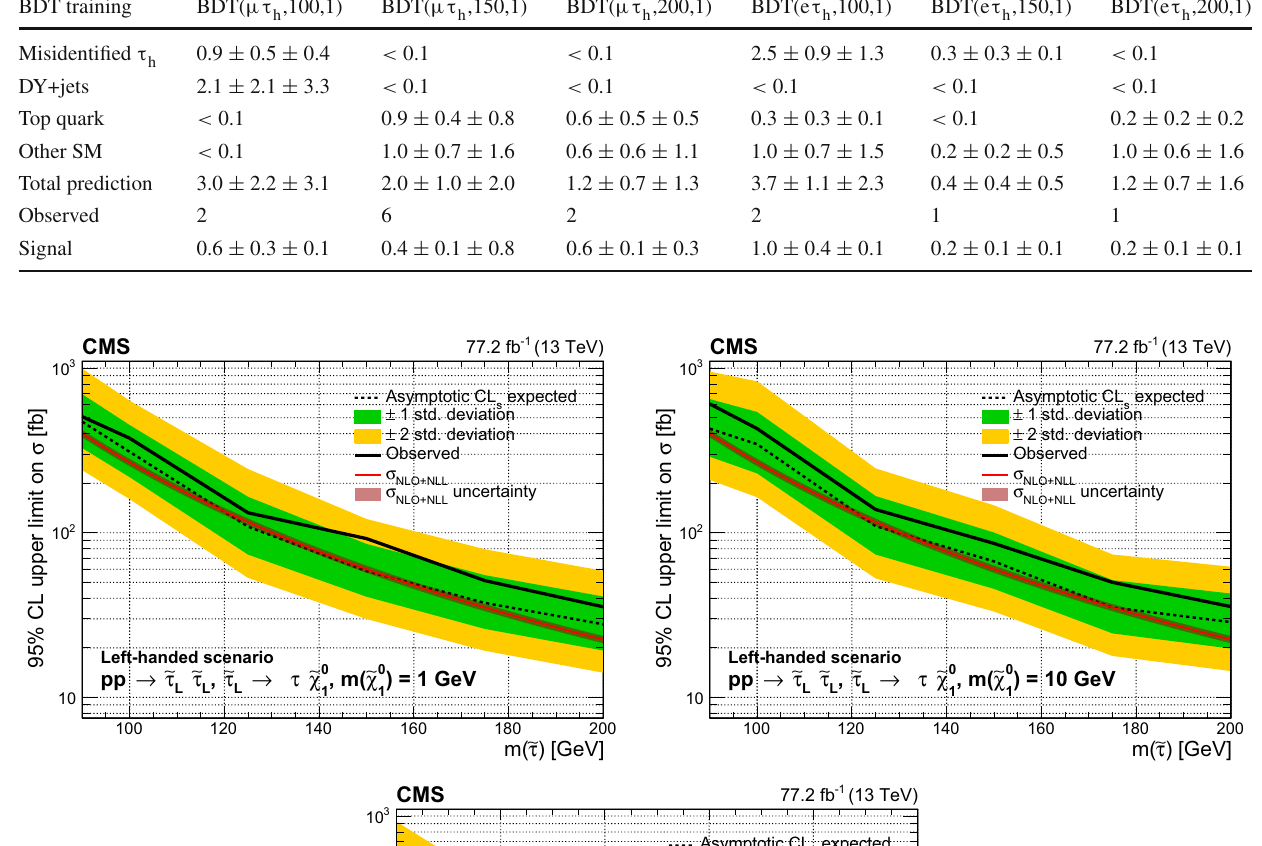
modeling. The reweighting factors are obtained from studies of Z boson events. We take the deviation of the reweighting factors from unity as a systematic uncertainty.